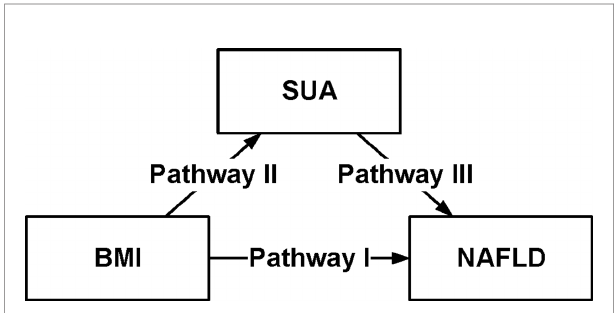
FIGURE 2 | Conceptual version of the model used in this analysis. Serum Uric Acid (SUA) mediates the association between body mass index (BMI) and non-alcoholic fatty liver disease (NAFLD), in 16,839 individuals in the Kailuan Group. Pathway I represented the direct effect, pathway II and pathway III represented the indirect